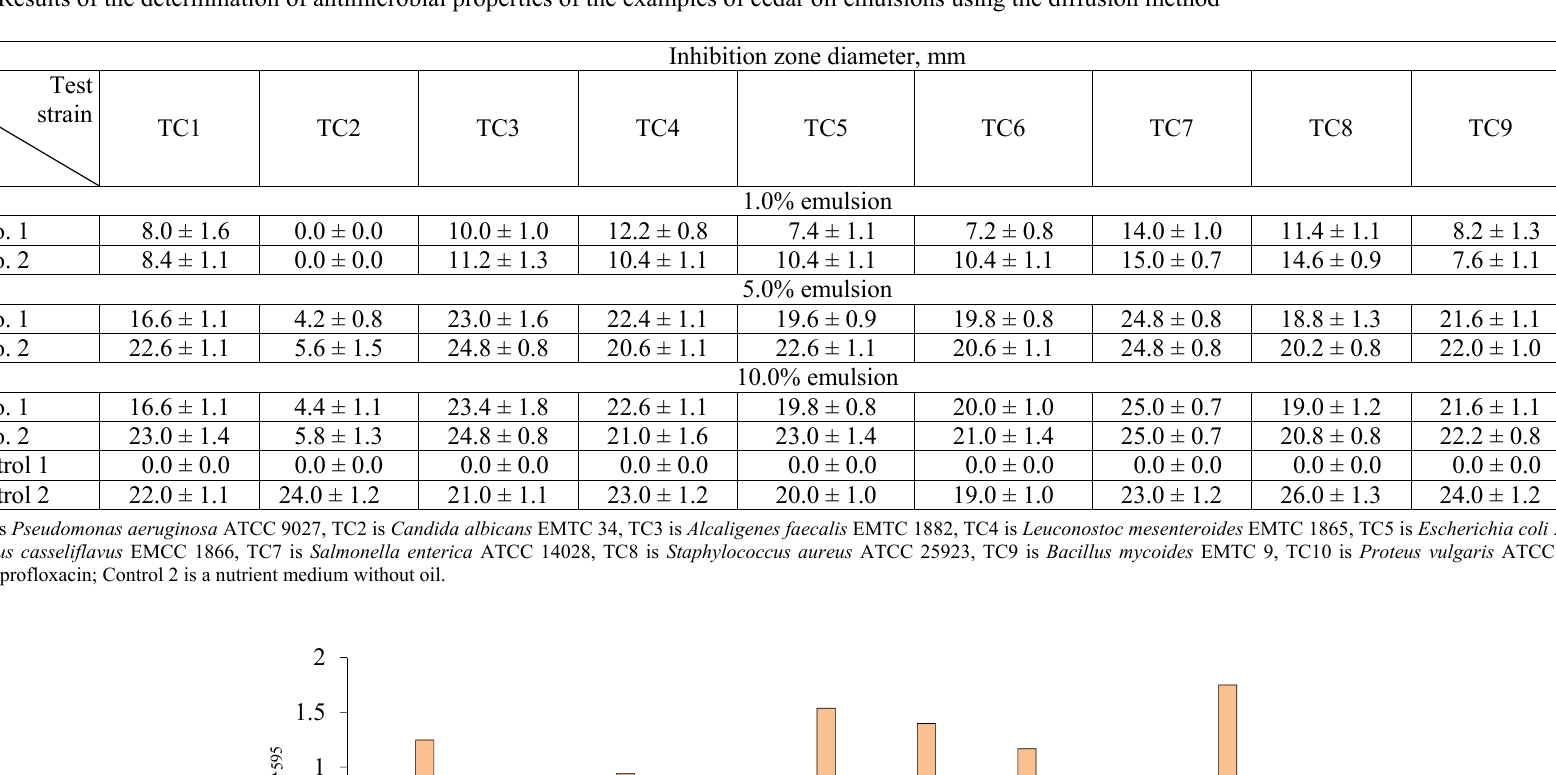
Table 1 . Results of the determination of antimicrobial properties of the examples of cedar oil emulsions using the diffusion method